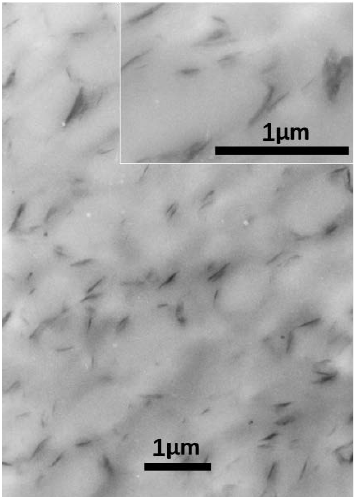
Figure 9. TEM images of the 70/30/1 wt. % PTT/PC/MMT melt processed at 250 °C, 60 rpm, and 10 min. The MMT is Cloisite ® 25A.